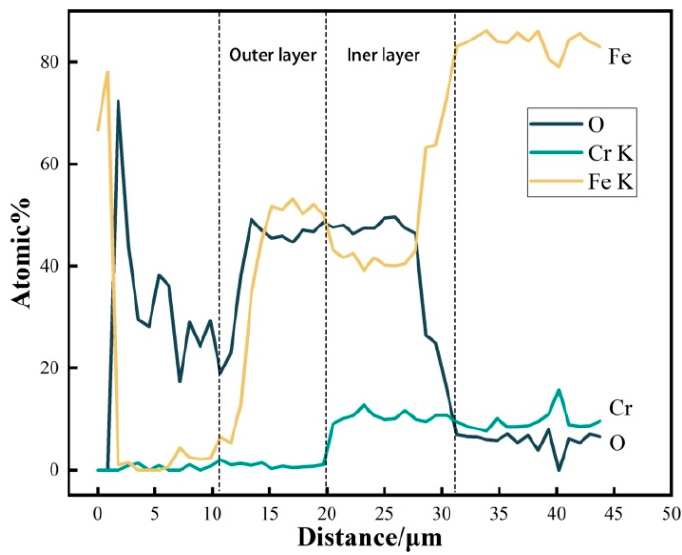
Figure 7. EDS line scanning of the T91 substrate exposed to LBE at 550 ◦ C for 500